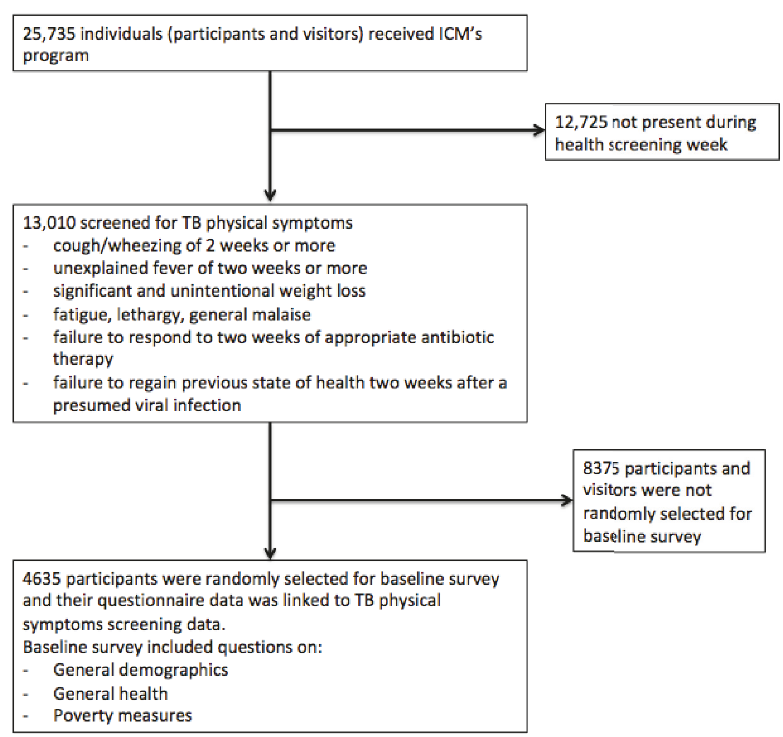
Figure 3: Number of participants at each step of the ACF